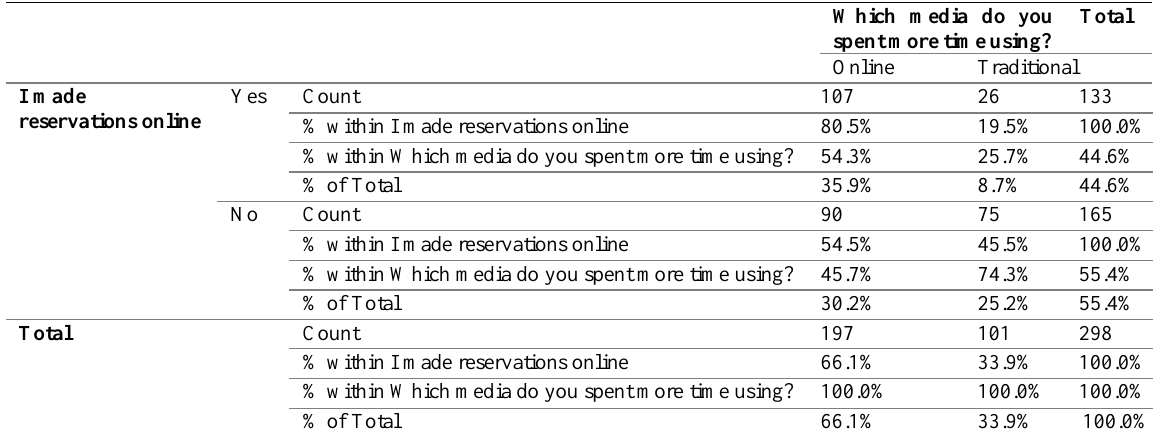
Table 8: Media used to make reservations